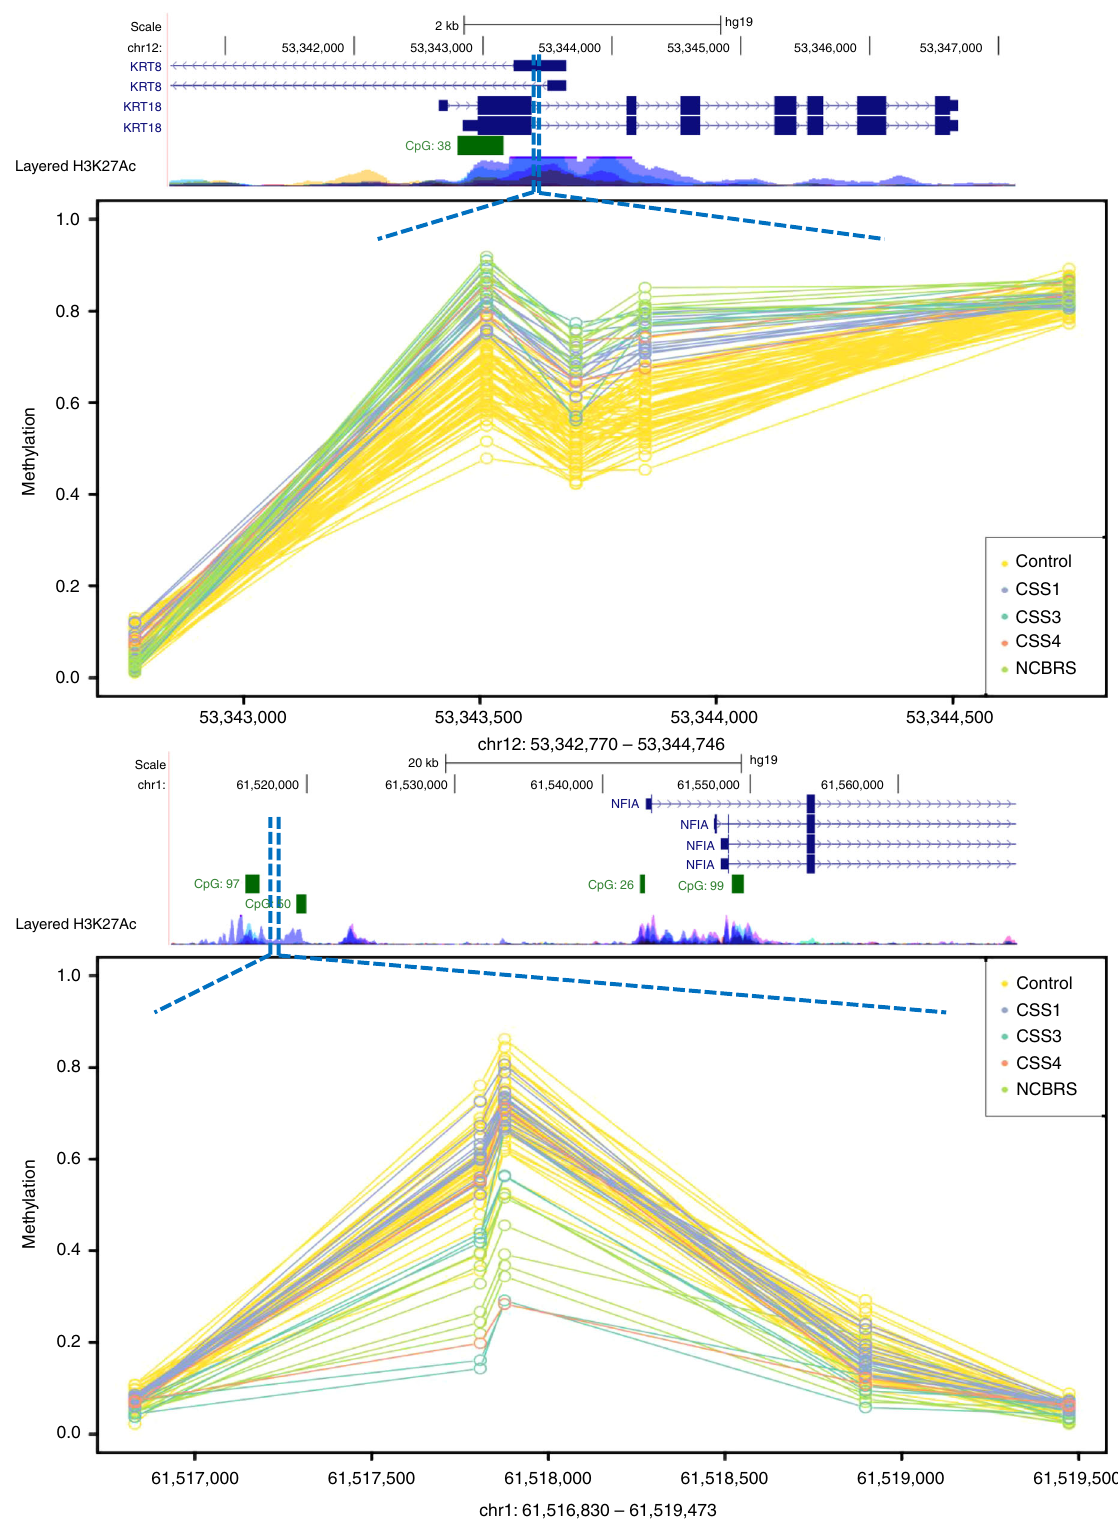
Fig. 4 Two genomic regions differentially methylated in CSS/NCBRS The top panel illustrates three consecutive probes annotating to the promoter of the KRT8 gene and the fi rst and second intron of two isoforms of KRT18 . The region is located in a segment highly enriched for H3K27 acetylation, a marker of active promoters. The methylation levels for every CpG (0 – 1) is shown using a circle, connected to the adjacent CpGs of the same individual using a line. Control subjects (yellow) show a hemi-methylation pattern in this region. All of the CSS/NCBRS cases show an increase in the methylation level of this segment. The lower panel depicts a segment upstream NFIA , located in a CpG island shore region with active H3K27 acetylation, potentially an active promoter. The region is hypomethylated in the CSS3 and NCBRS cases as compared to the controls; however, no difference is observed between CSS1 and controls for this segment. It is noticeable that one of the two CSS4 subjects shows a hypomethylation pattern similar to CSS3 and NCBRS, whereas the other one tends to be similar to controls and CSS1